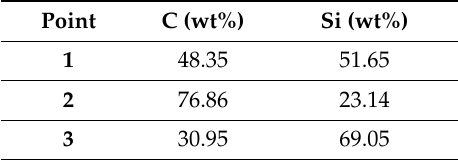
Table 2. EDS results for the SiC powder products (related to Figure